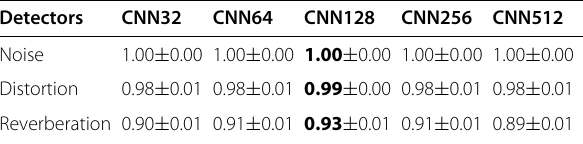
Table 1 Comparison between the performance of different CNN architectures on the pathological voice data set in the